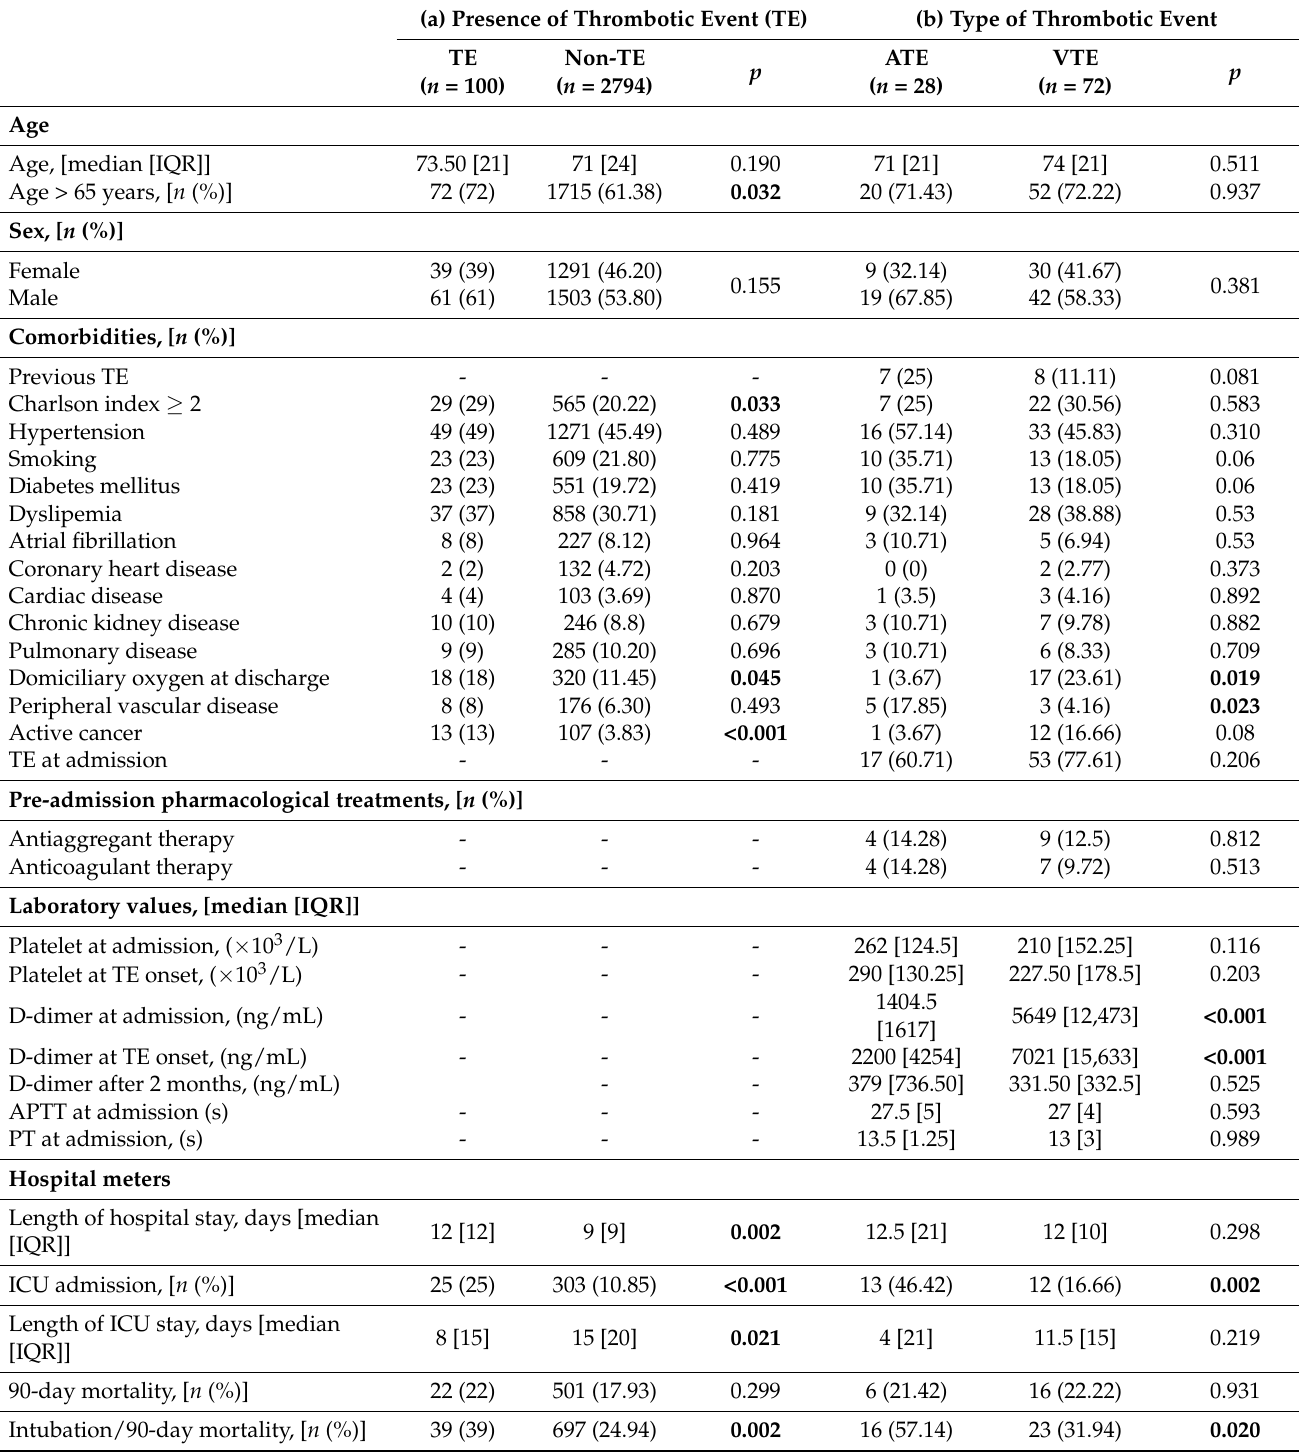
Table 1. (a) Clinical characteristics of hospitalized COVID-19 patients according to the diagnosis of thrombotic events (TE). (b) Different characteristics between arterial and venous thrombotic